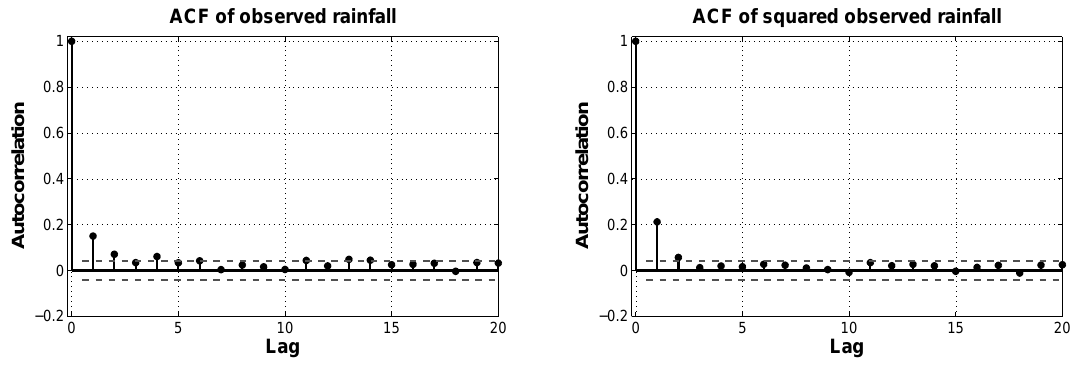
Fig. 4. Autocorrelation function for precipitation (1979–1993) of Garmisch-Partenkirchen, Germany (left), and its corresponding squared time series (right).